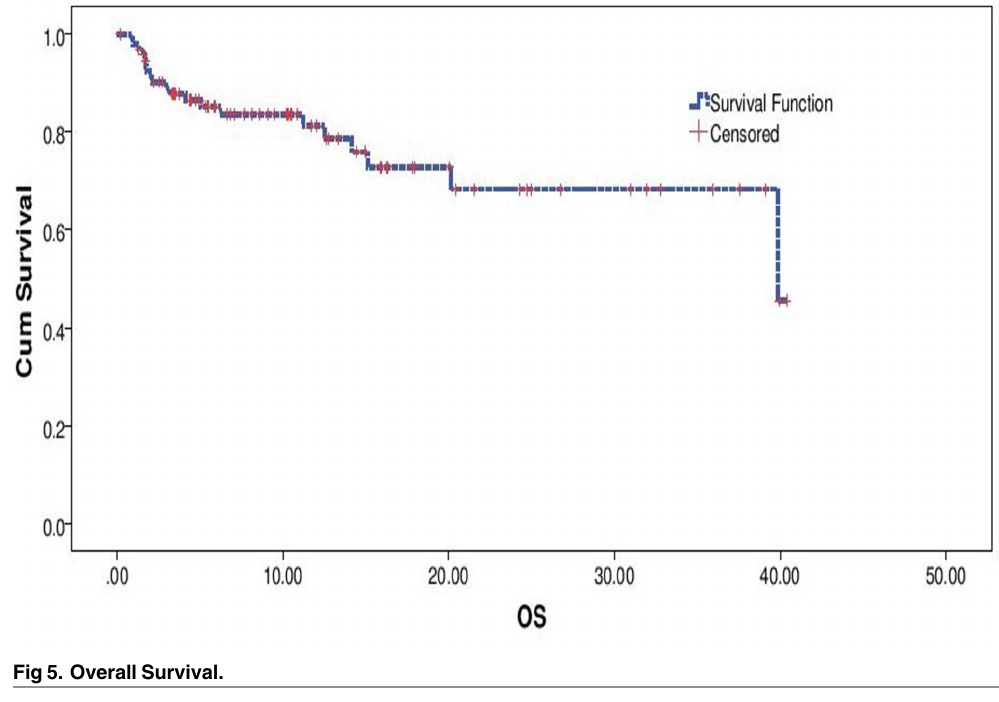
Fig 5. Overall Survival.